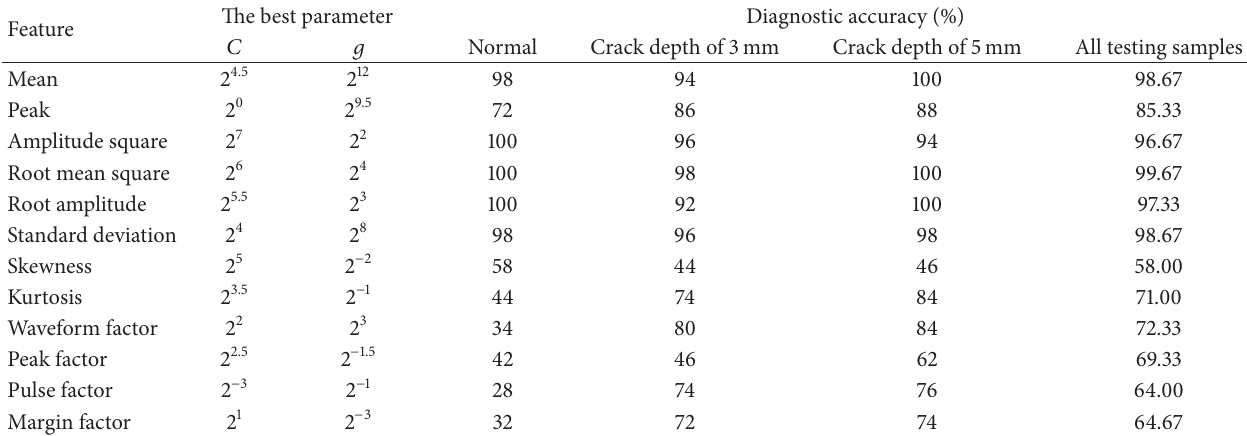
Table 6: Diagnostic results of rotor crack by using different features for